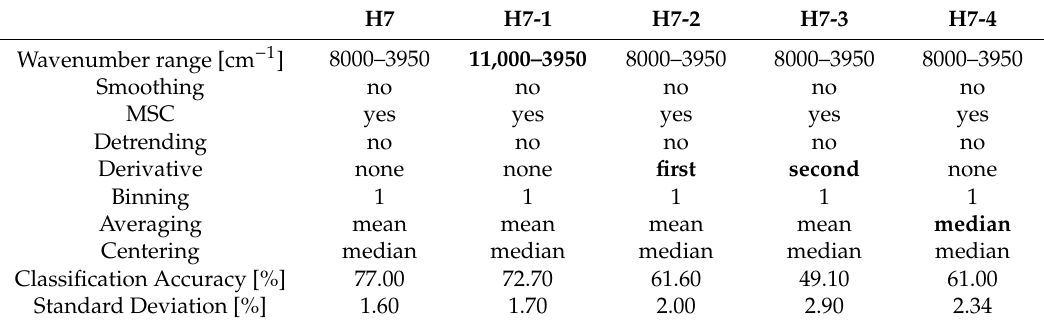
Table 2. Pre-processing strategies based on combination H7—showing the impact of changing one parameter at a time (highlighted as bold ) on the classification accuracy. The aforementioned classification accuracies are based on LDA of all 212 walnut samples in a 20-fold repetition of the nested